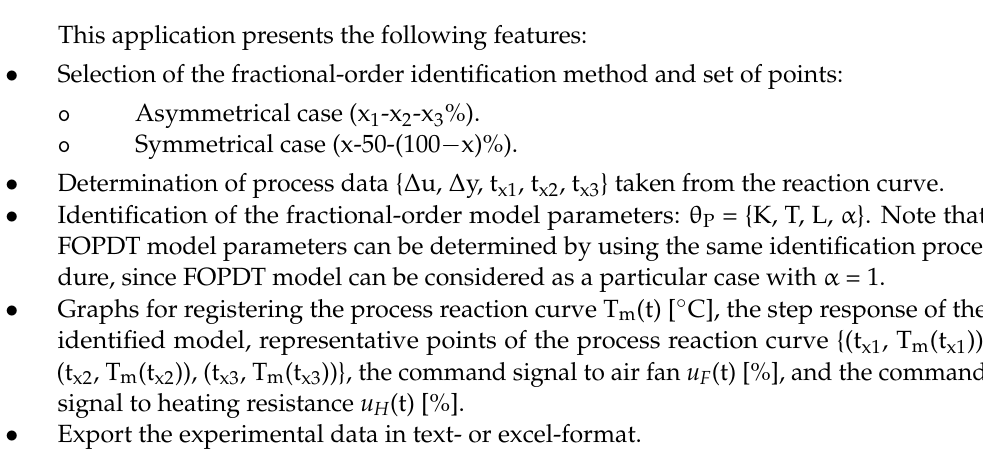
Figure 19. Application programmed with LabVIEW for the implementation of fractional-order identification algorithms.